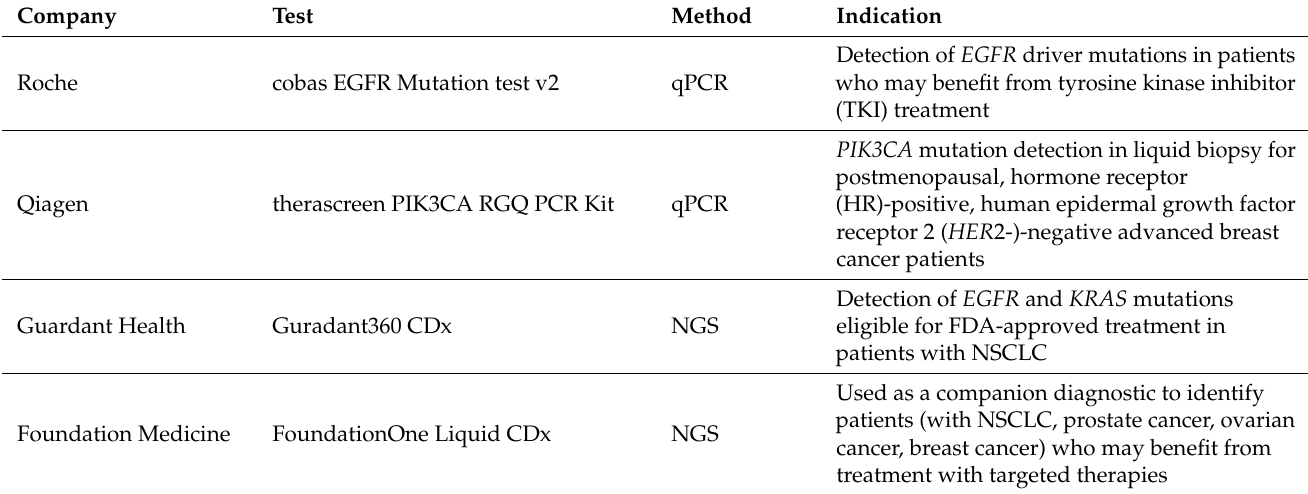
Table 2. FDA-approved LP